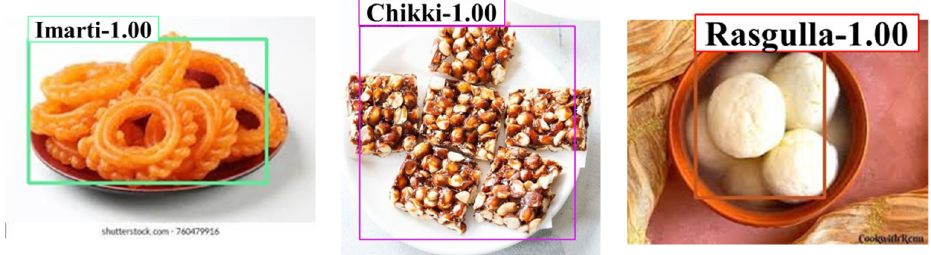
Figure 7. Recognition results on Indian cuisine open data.